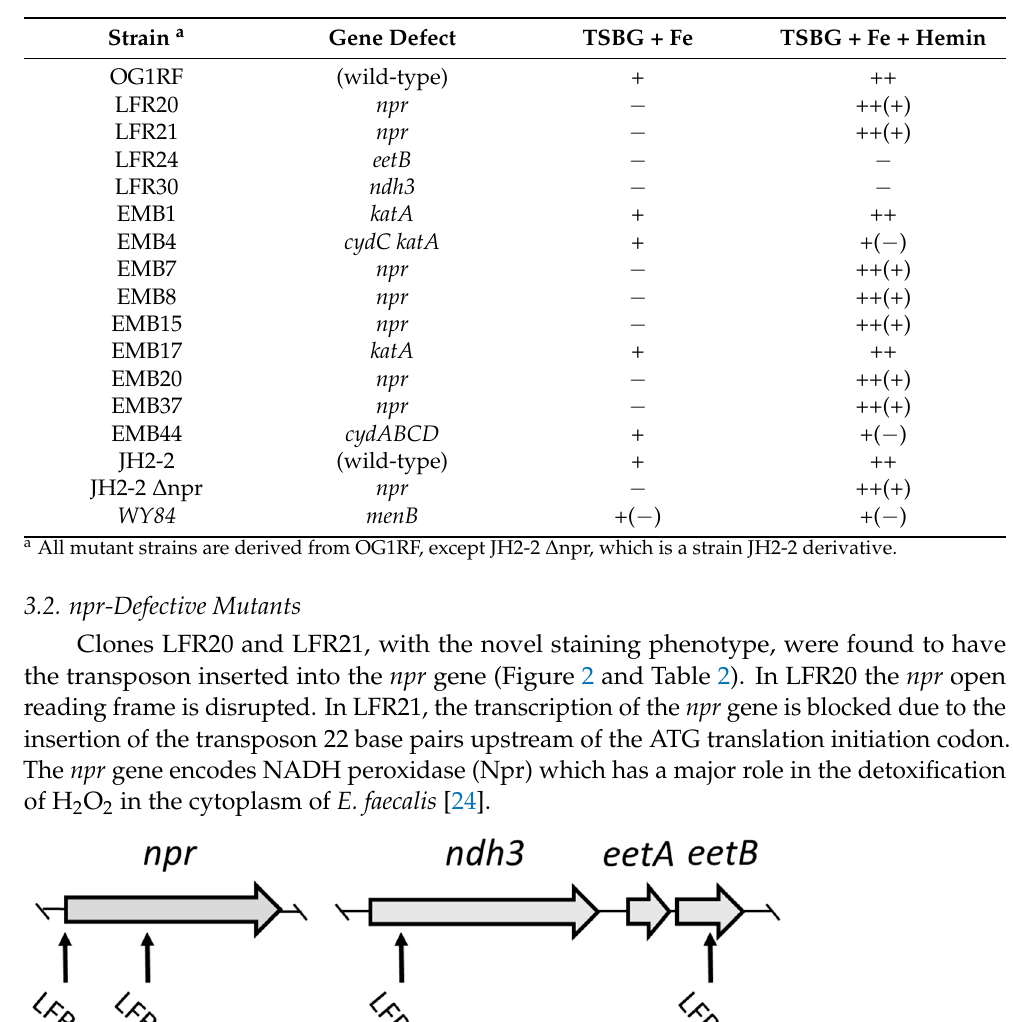
Table 1. Summary of relative Ferrozine staining activity of colonies grown on TSBG plates supple- mented with 0.2 mM ammonium iron(III) sulfate (Fe) and + 5 µM hemin. +, magenta stain intensity similar to the parental strain OG1RF grown without hemin; -, weak stain; +(-), intermediate stain; ++, strong stain; ++(+), stain stronger than for the parental strain grown with hemin.